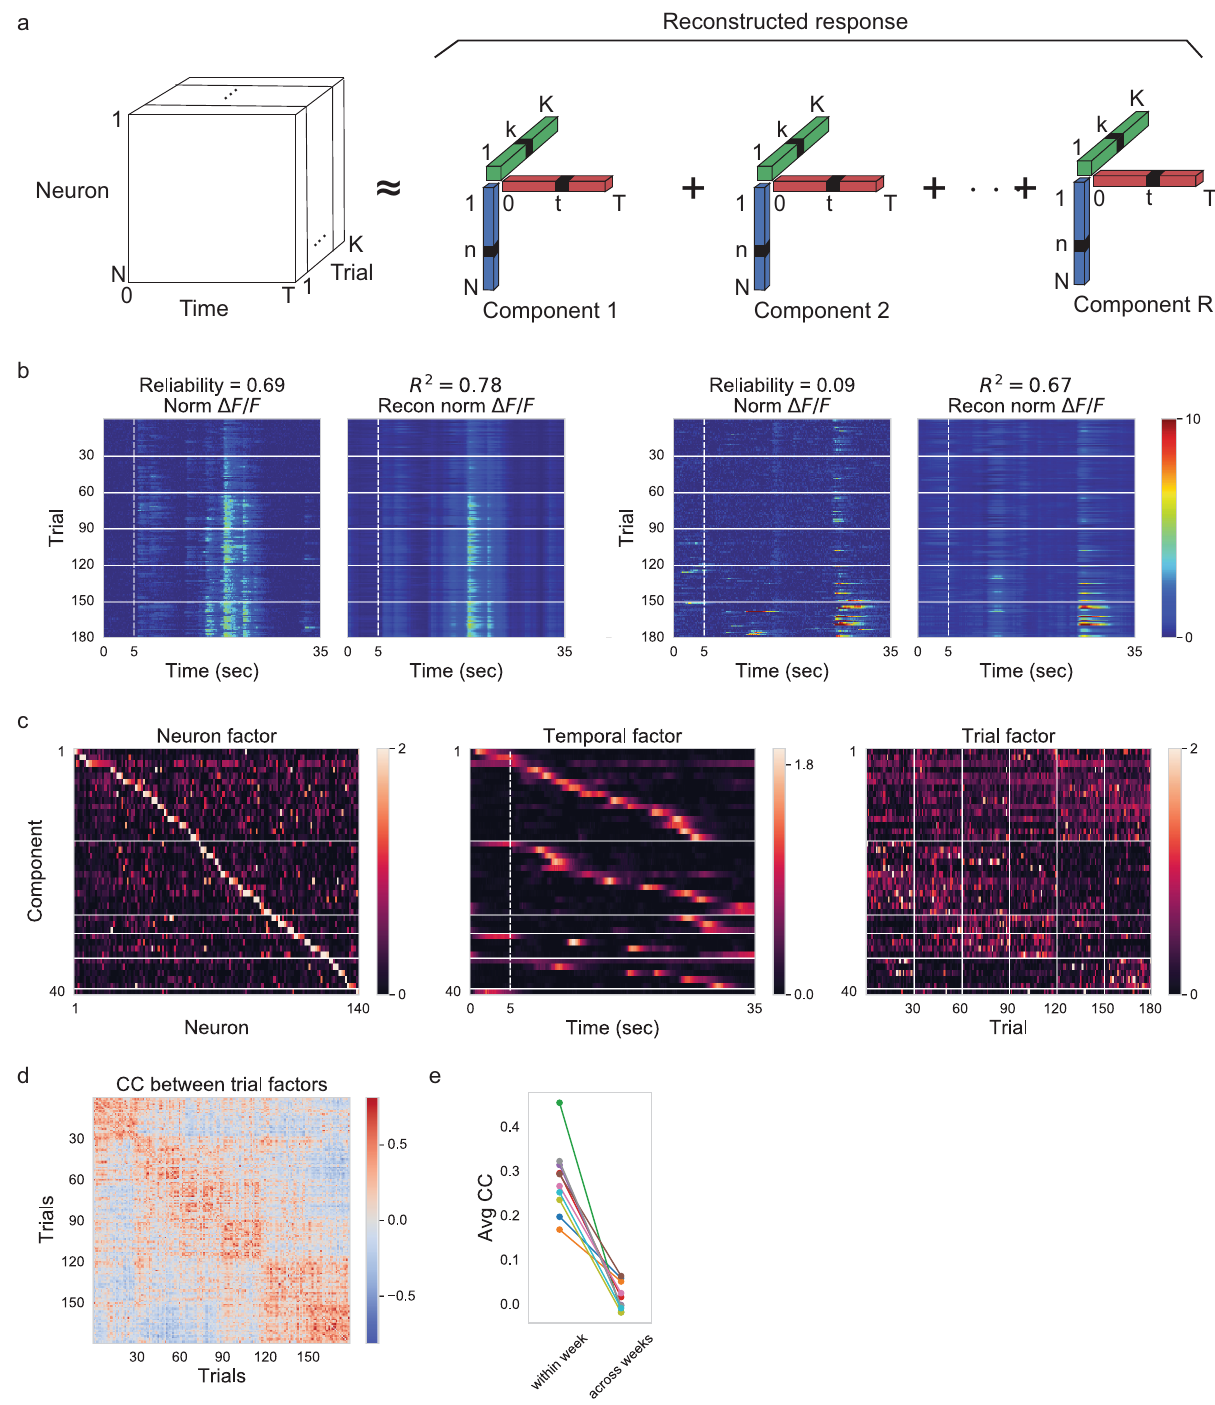
mean squared error) for time in the movie of the test set. We did this because when we assigned coordinates to the spline, the origin and direction of the coordinates were arbitrarily determined. To match the assigned coordinates with the actual time, we need to determine the origin and direction of coordinates using the test set. The decoded time α closely traced the actual time t in the movie for population activity across weeks (Fig. 5b). We sum- marized the decoding error (circular absolute difference between t and α ) from all the recorded imaging fi elds (Fig. 5c). As a com- parison, the decoding error of SPUD was signi fi cantly lower than the decoding error from that of linear decoders (Supplementary